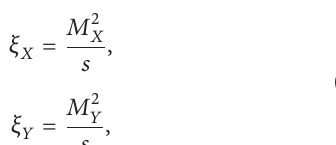
= 𝑚 𝑚 𝑌 𝑝 , where 𝑝